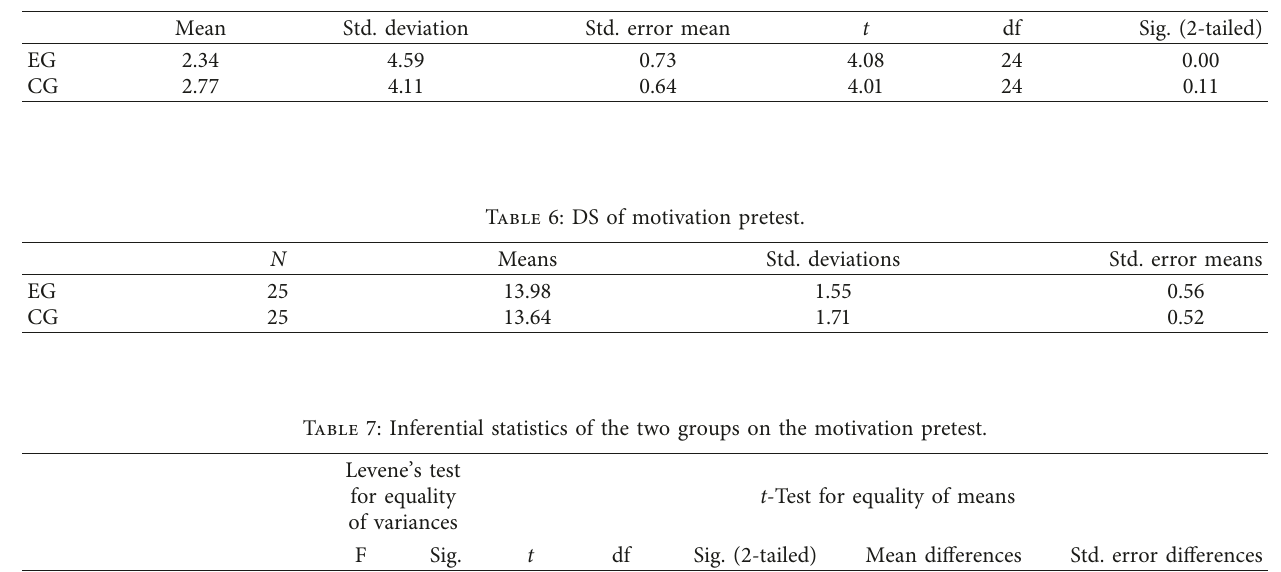
Table 5: Paired-samples test (pre- and posttests of each group).